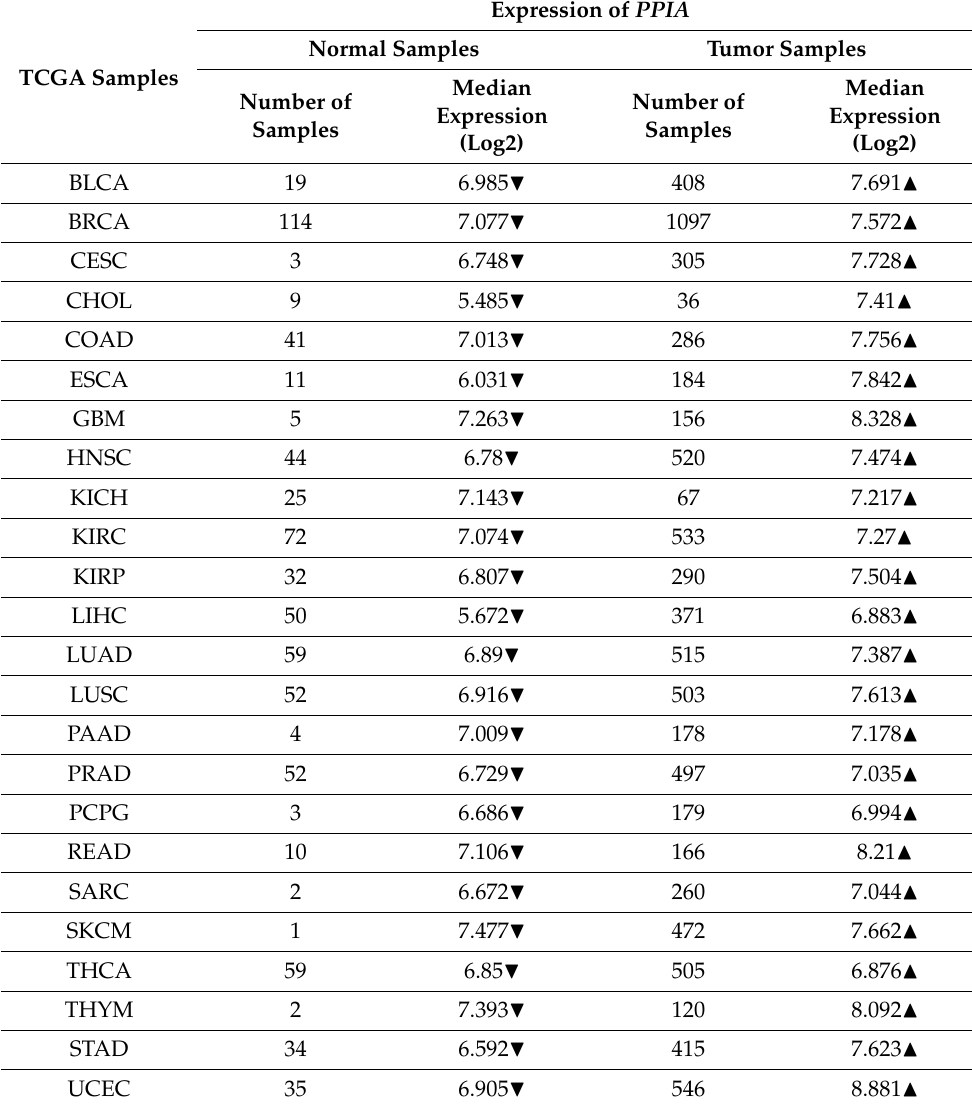
Table 3. The mRNA expression levels of PPIA in normal and tumor